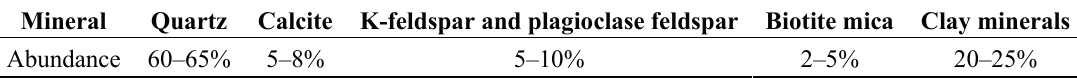
Table C2. Mineralogy of six samples: P11, P15, P24, P27, P31A, and P34.